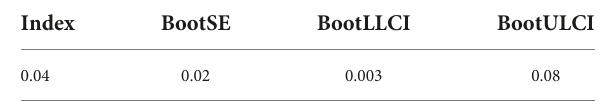
TABLE 5 Index of conditional indirect model.